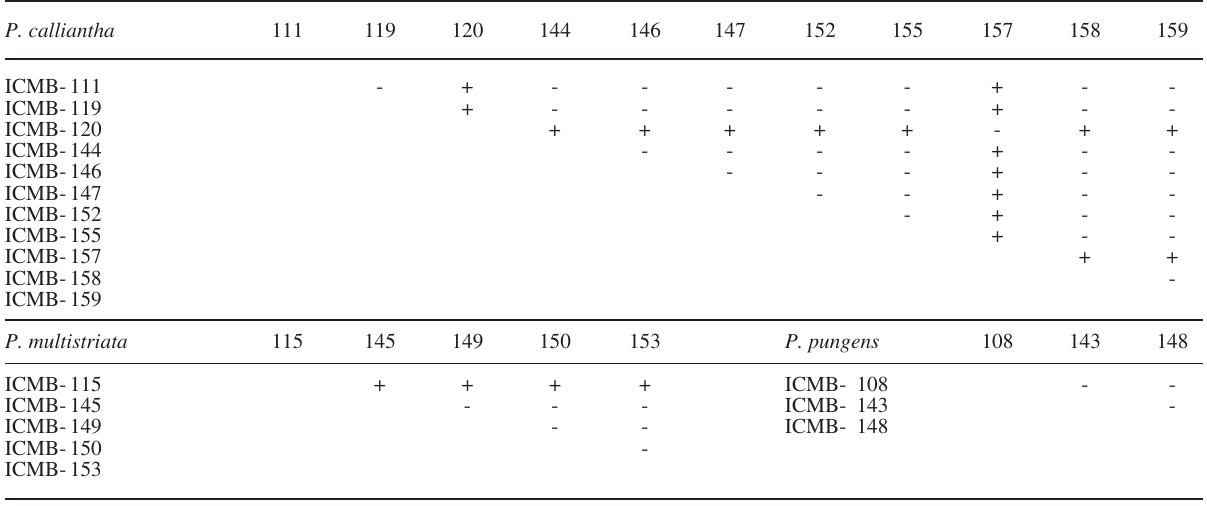
Table 5. – Mating compatibility tests for Pseudo-nitzschia calliantha , P. multistriata and P. pungens isolated from the NW Mediterranean Sea. The presence of auxospores is indicated with +, and - when not present. For successful mating compatibility in P. brasiliana , P. delicatis- sima , P. arenysensis see Quijano-Scheggia et al., 2009a and b respectively. P.